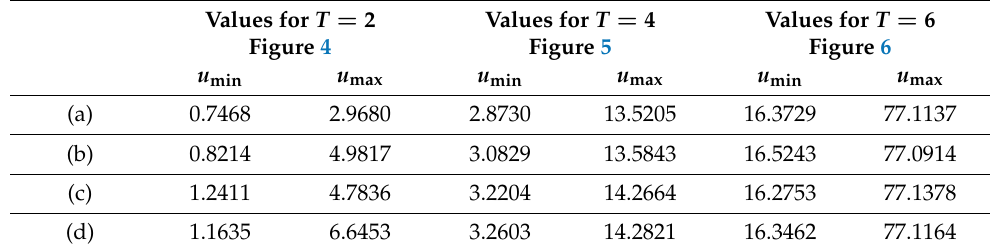
Table 5. Minimal and maximal values of the controlled state u at T = 2,4,6 for cases I, II, III, and IV depicted in Figures